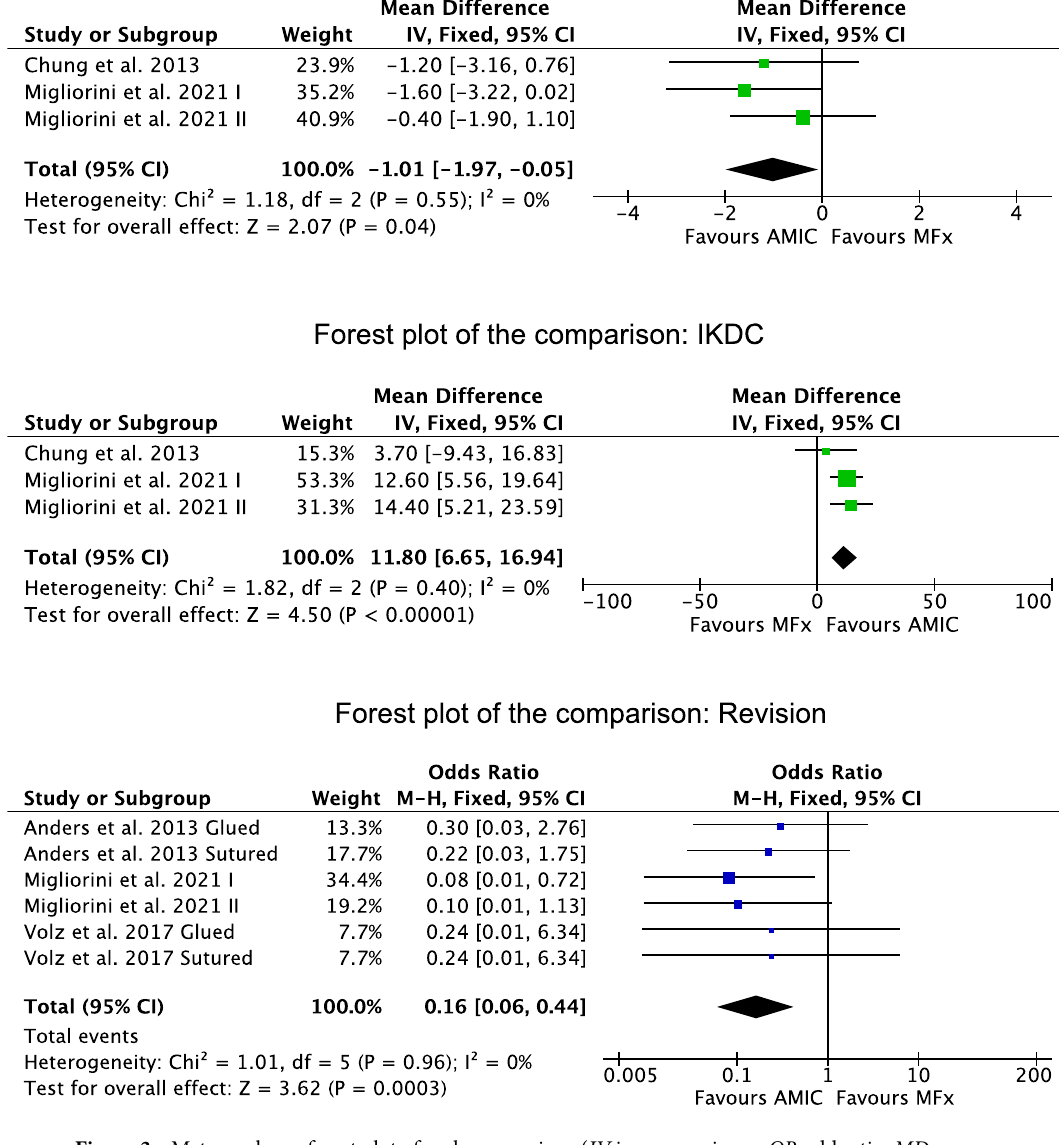
Figure 3. Meta-analyses: forest plot of each comparison ( IV inverse variance, OR odd ratio, MD mean difference, MH Mantel–Haenszel, CI confidence interval). The final effect and the relative confidence interval are represented respectively by the diamond and its lateral ends. The vertical line indicates the no effect threshold. The effect and the respective confidence interval of each study are represented by the square and the horizontal line,